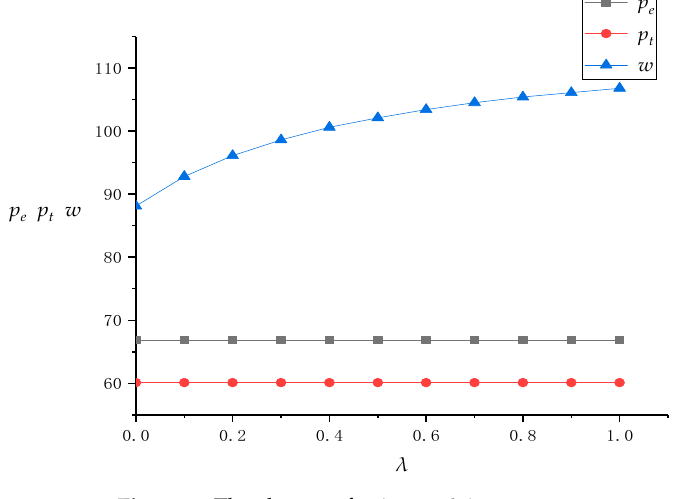
Figure 2. The change of prices as λ increases.